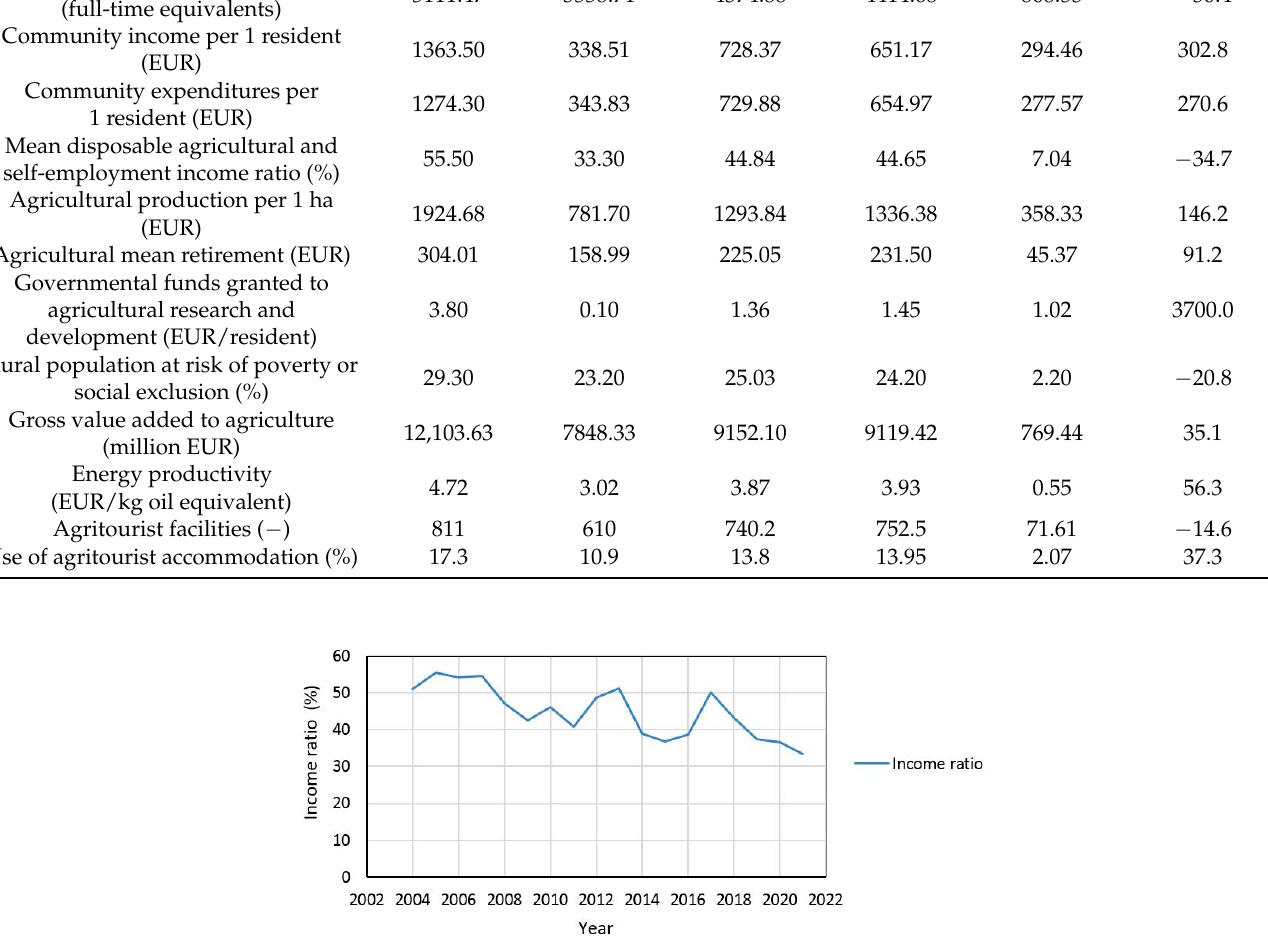
Figure 22. Mean disposable agricultural income related to self-employment income in Poland, 2004–2021, data obtained from [66].